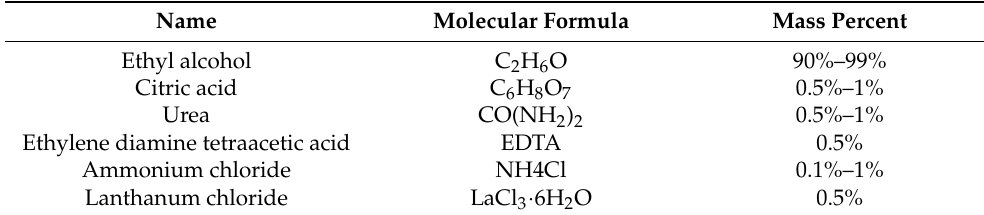
Table 1. Composition of the rare earth modification